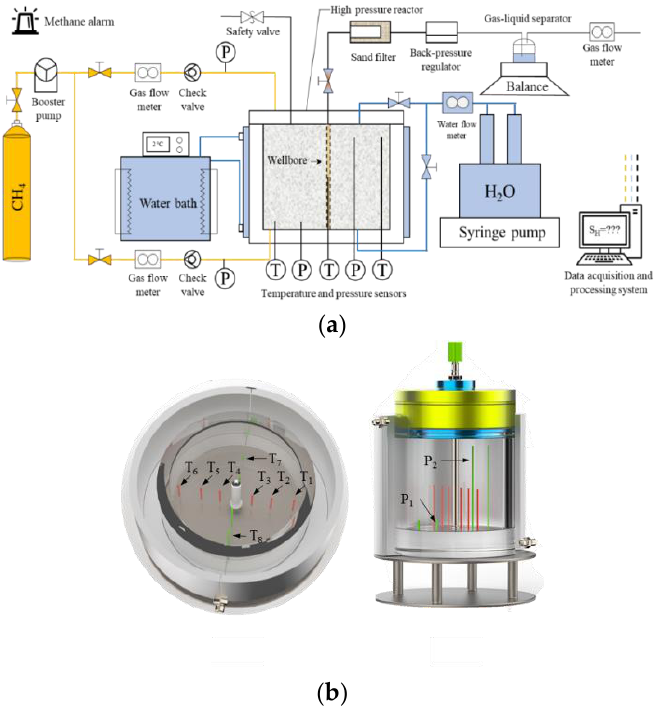
Figure 3. ( a ) Schematic diagram of the hydrate synthesis and development equipment; ( b ) Top view and side view of the distribution of sensors.